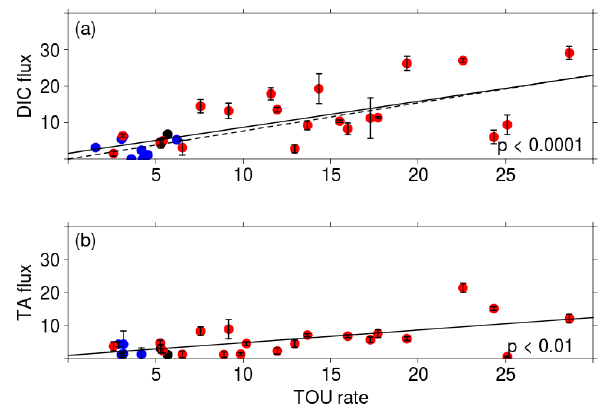
Figure 8. (a) Correlation between DIC fluxes and TOU rates. (b) Correlation between A T fluxes and TOU rates. Solid line: lin- ear regression; Spearman’s p value given in each plot. TA and DIC